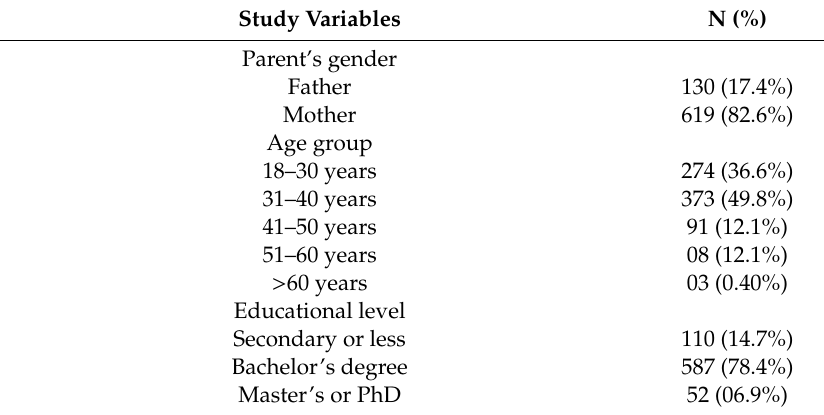
Table 1. Sociodemographic characteristics of parents ( n =